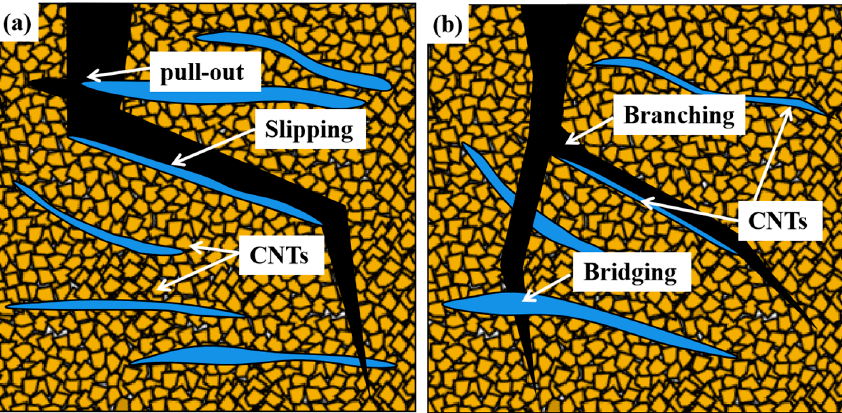
Figure 13. Toughening mechanism of gnts ( a ) pull-out and slipping, ( b ) bridging and crack deflec- tion.